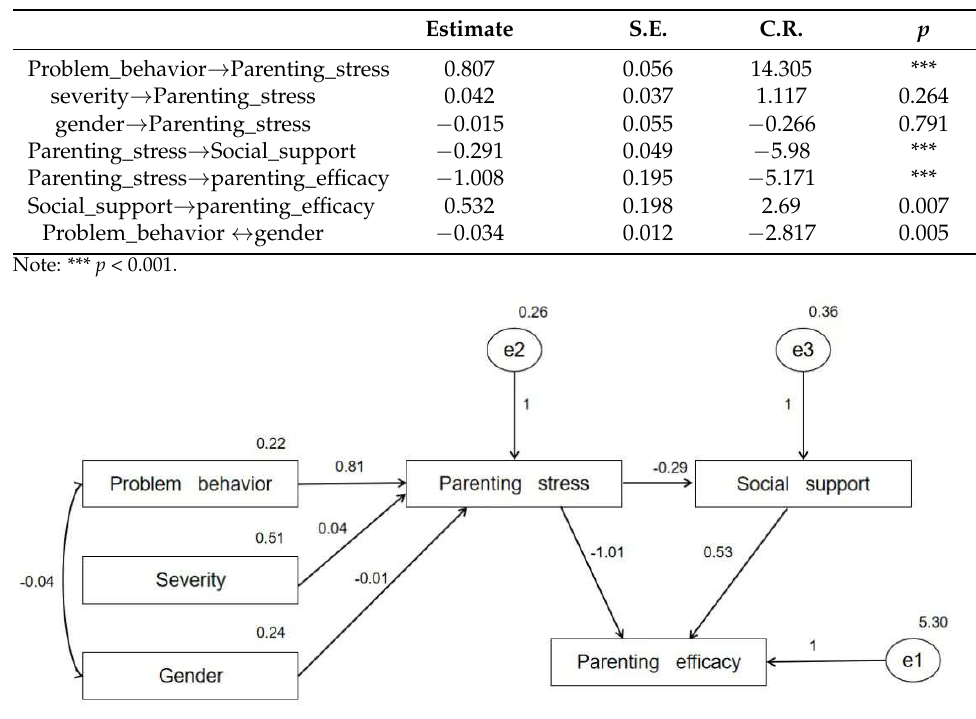
Figure 1. The path of the structural equation model.